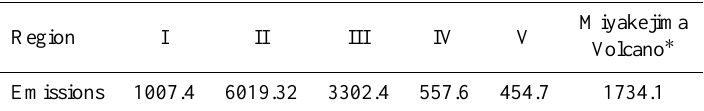
Table 3. Emissions of sulfur (ktonSyr − 1 ).